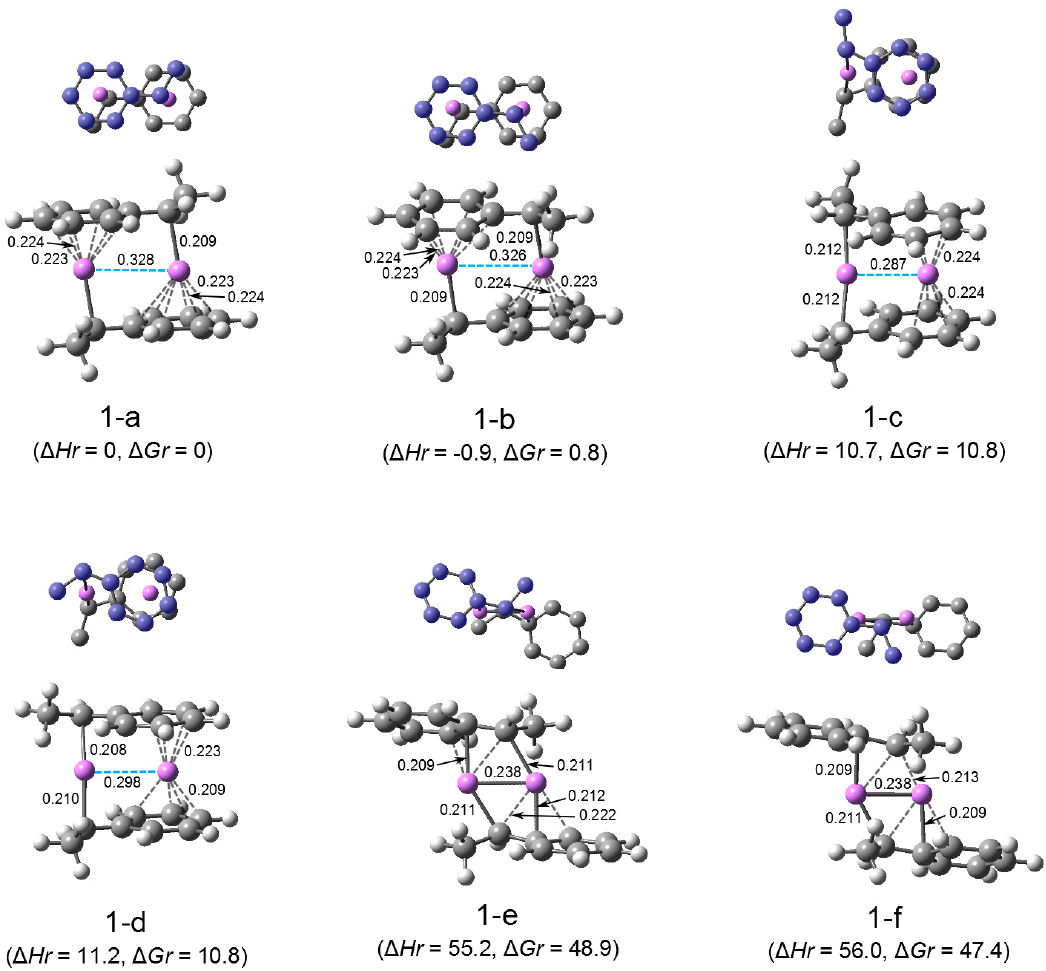
Figure 1-1. Optimized geometries and relative energies of (HStLi) 2 in the gas phase. The small drawing on the upper part of each structure is the simplified overhead view of the lower drawing; the carbon atoms of one HStLi (the upper HStLi in the lower drawing) are colored in blue. In the lower drawings, C–Li distances less than 0.225 nm are shown. ∆ Hr and ∆ Gr , the relative enthalpy and relative free energy, are expressed in kJ·mol –1 .